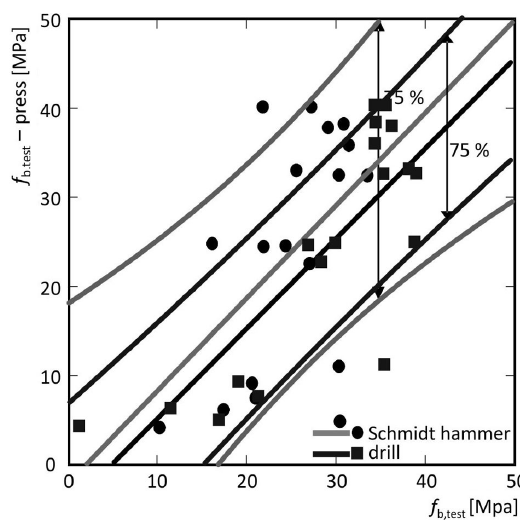
Fig. 10. Strengths of masonry units obtained by the Schmidt hammer or the drill and a